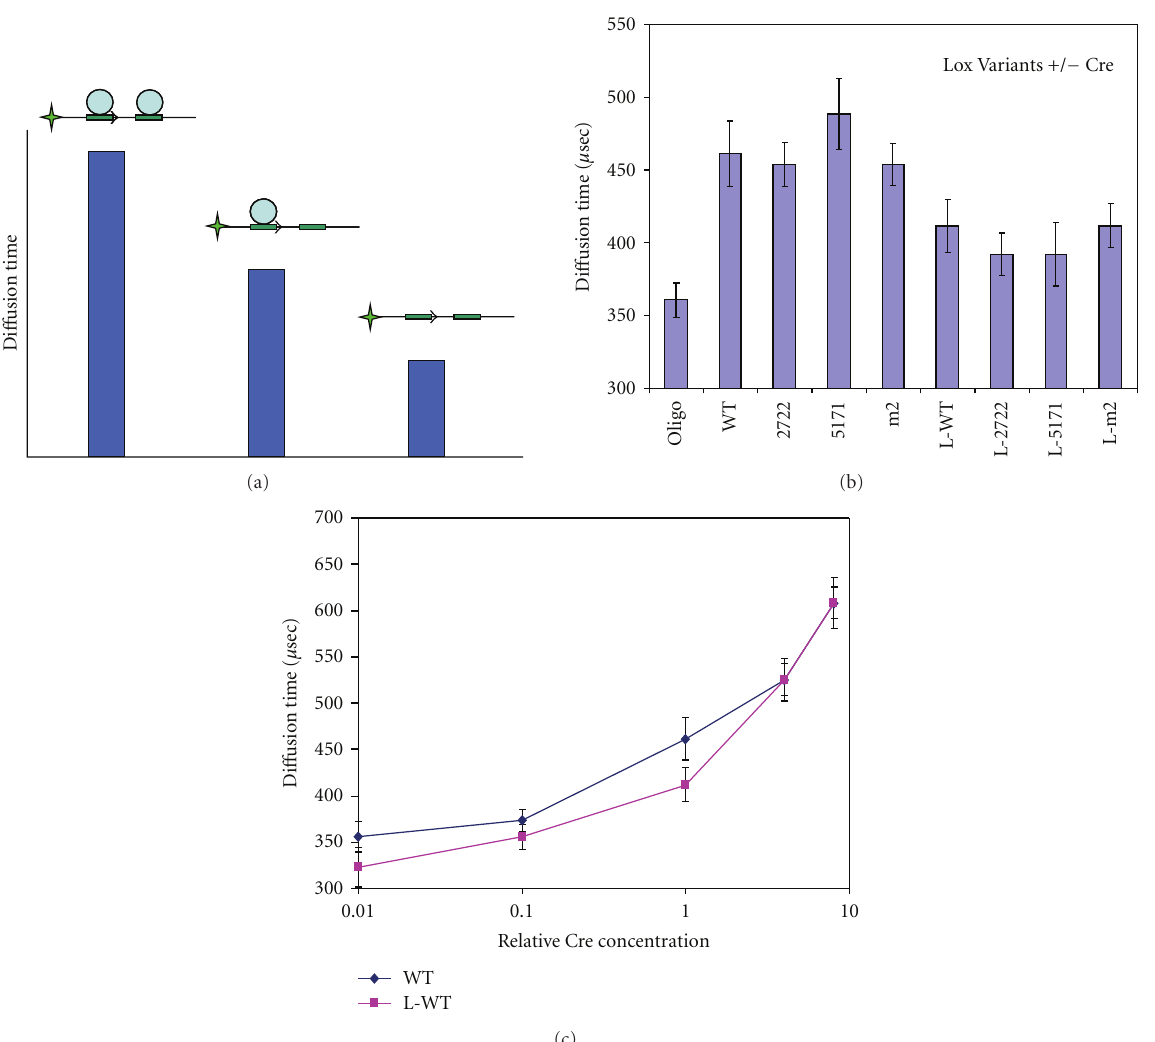
Figure 3: Measure of Cre a ffi nity for sites by FCS microscopy. (a) Strategy to measure Cre a ffi nity for sites: The di ff usion time of labeled oligos as measured by FCS increases depending upon the number of Cre molecules bound. Labeled oligo unbound by Cre would exhibit the highest di ff usion rate (shortest di ff usion time) (right). Labeled oligo with a single Cre molecule bound would have a decreased di ff usion rate (increased di ff usion time) (middle). Labeled oligo with both inverted repeat sites occupied by Cre would have the lowest di ff usion rate (longest di ff usion time) (left). (b) Di ff usion times of Alexa 488-labeled PCR products containing Lox sites were measured by FCS. The times for Lox fragment alone and Lox fragments in the presence of Cre (2.5U/50 ul) were displayed in micro seconds ( μ s) with error bars showing the standard error of the mean. (c) Di ff usion times of Alexa 488-labeled PCR products containing a LoxP or a L-LoxP site were measured by FCS for 10-fold dilutions of Cre. Times were displayed in micro seconds ( μ s) with error bars showing the standard error of the mean. LoxP shown in blue and L-LoxP shown in